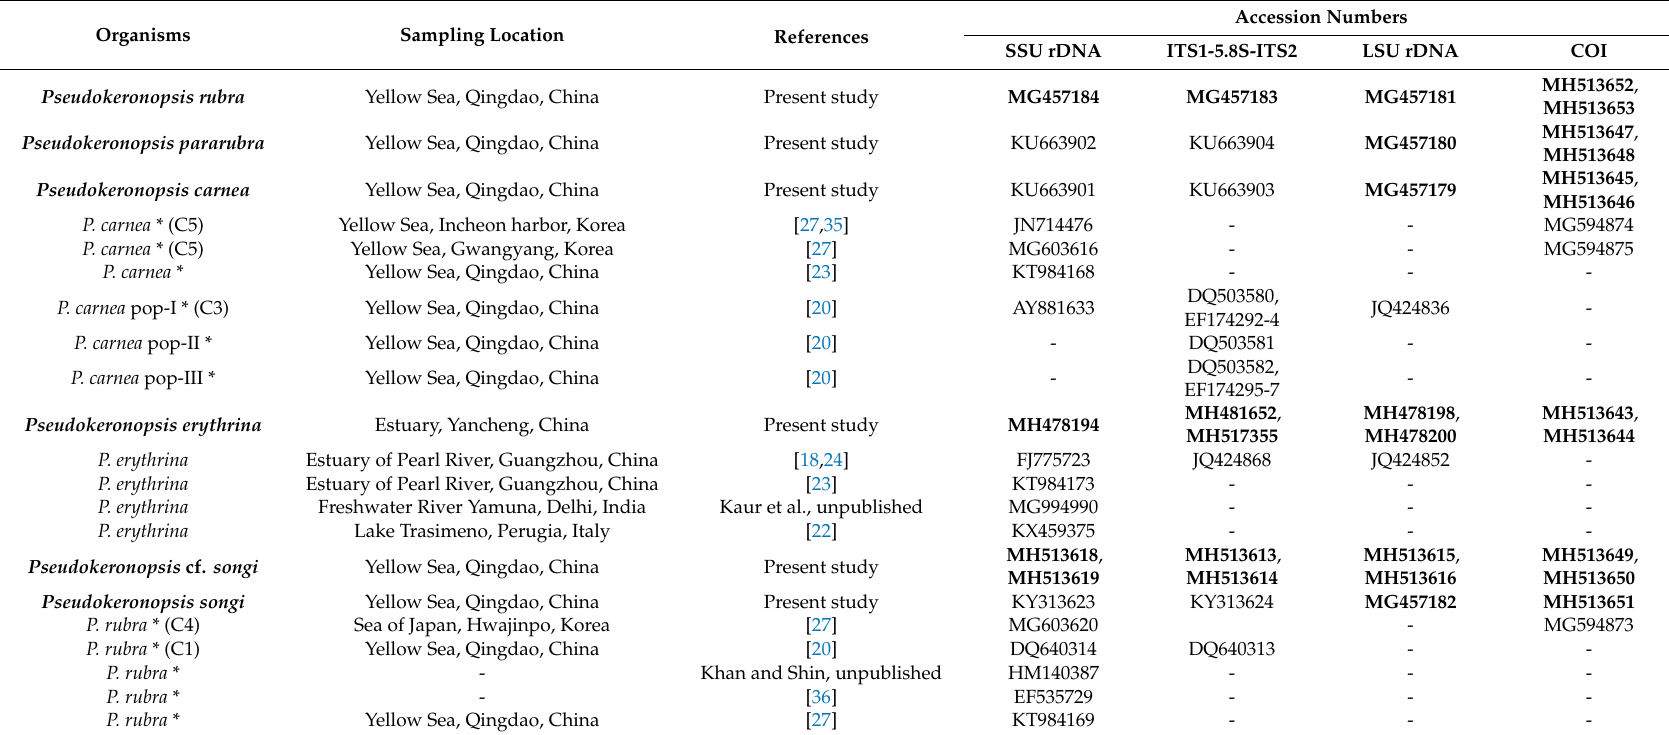
Table 1. Specifications of the Pseudokeronopsis spp. in the present research. Newly obtained sequences are in